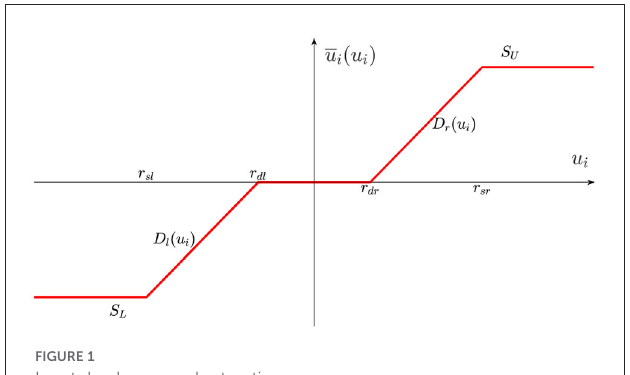
FIGURE1 Input dead zone and